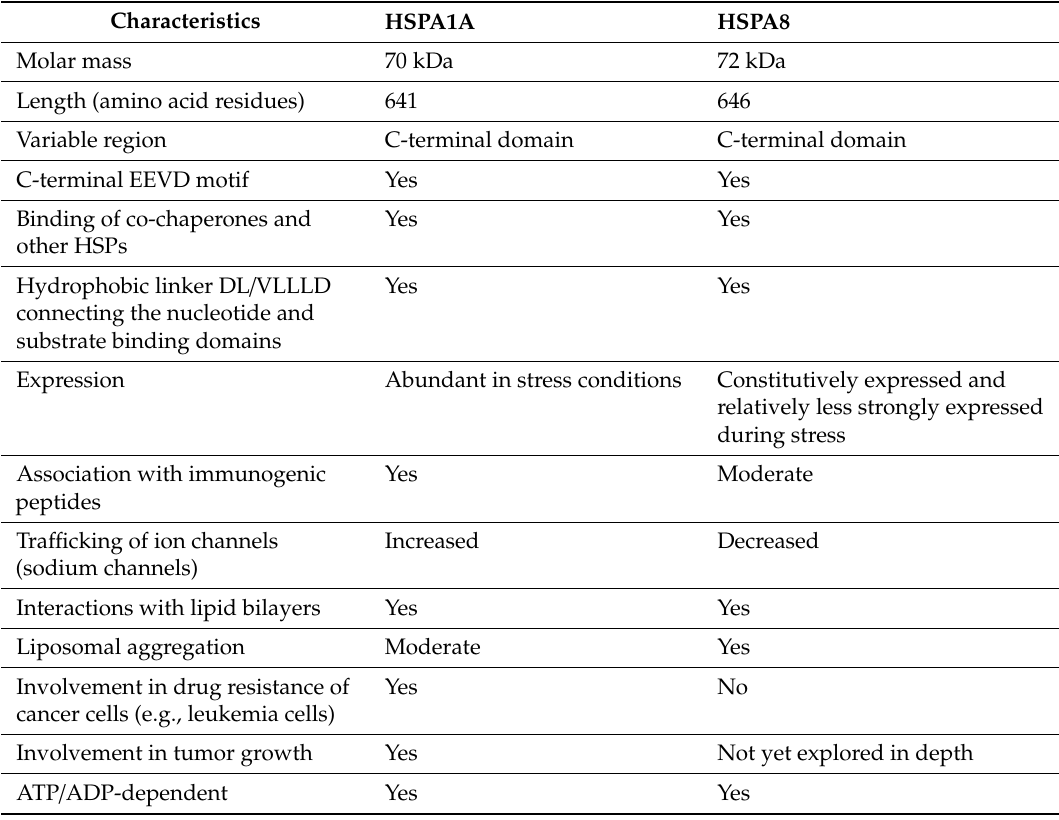
Table 1. Di ff erences between HSPA1A and HSPA8 [1–3], (where HSP represents heat shock proteins).